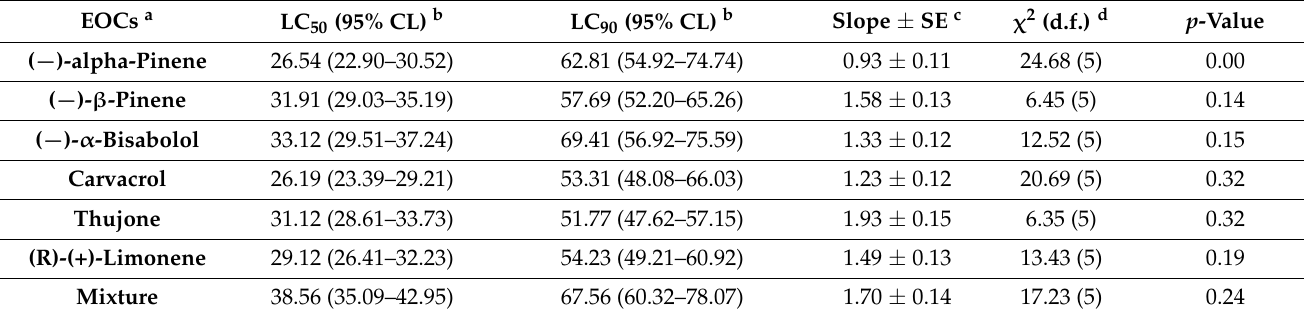
Table 5. Toxicity of different EOCs against B. dorsalis